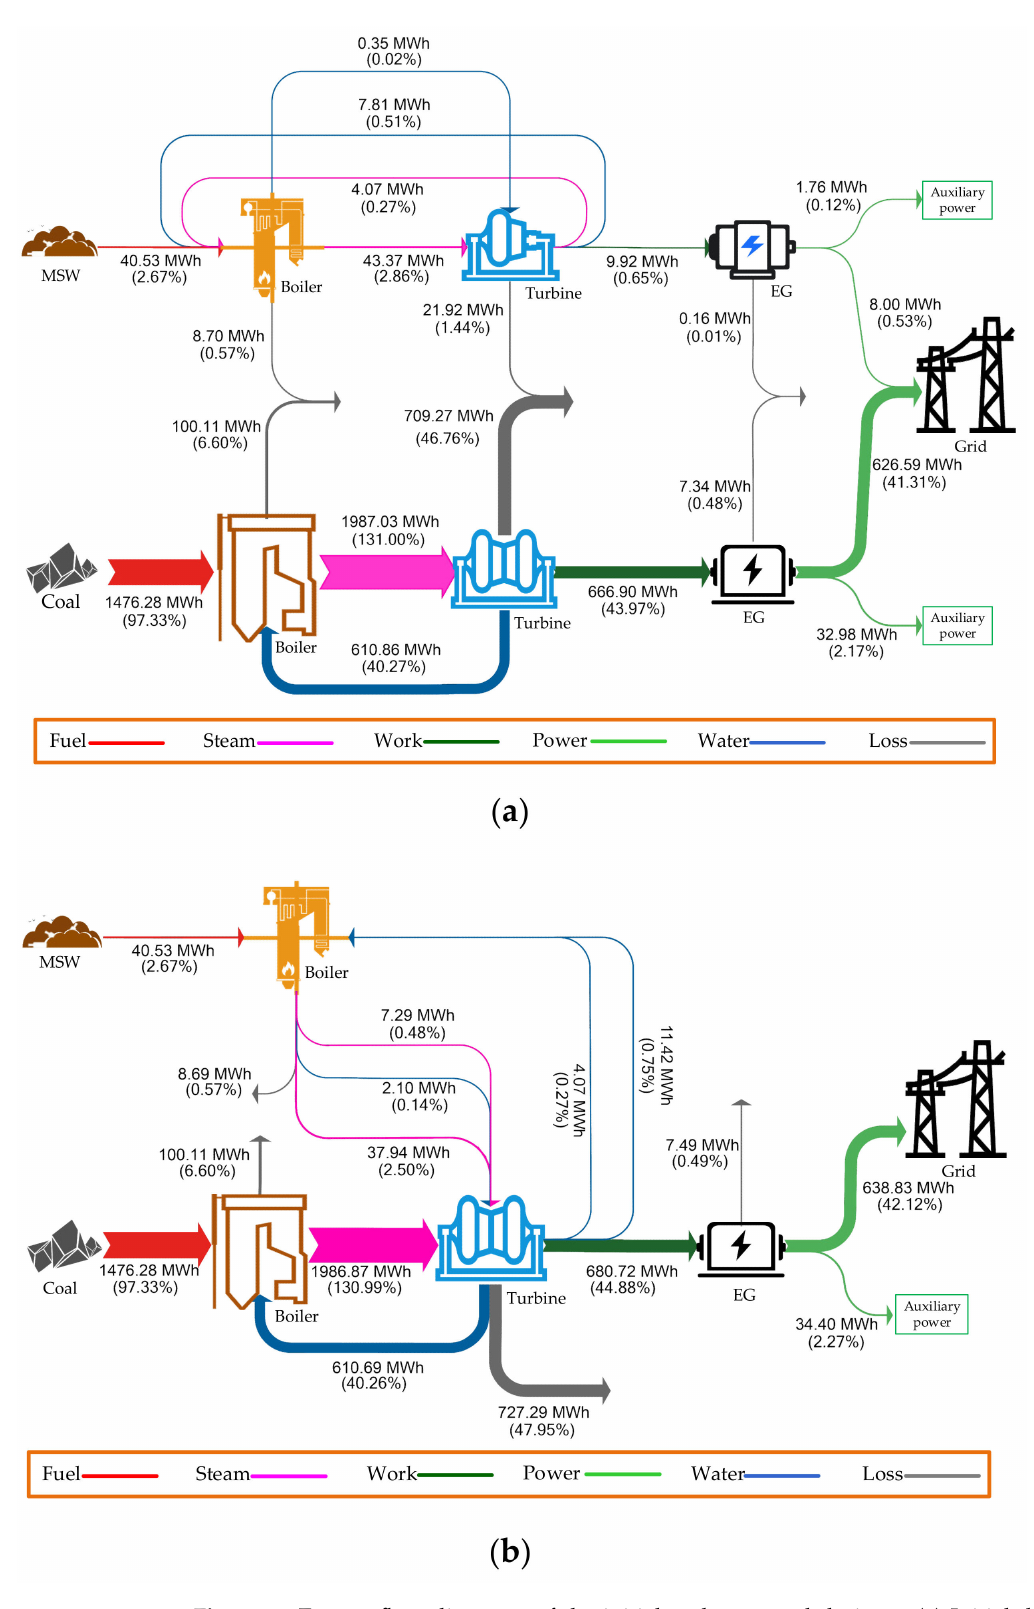
Figure 5. Energy flow diagrams of the initial and proposed designs. ( a ) Initial design; ( b ) pro- posed